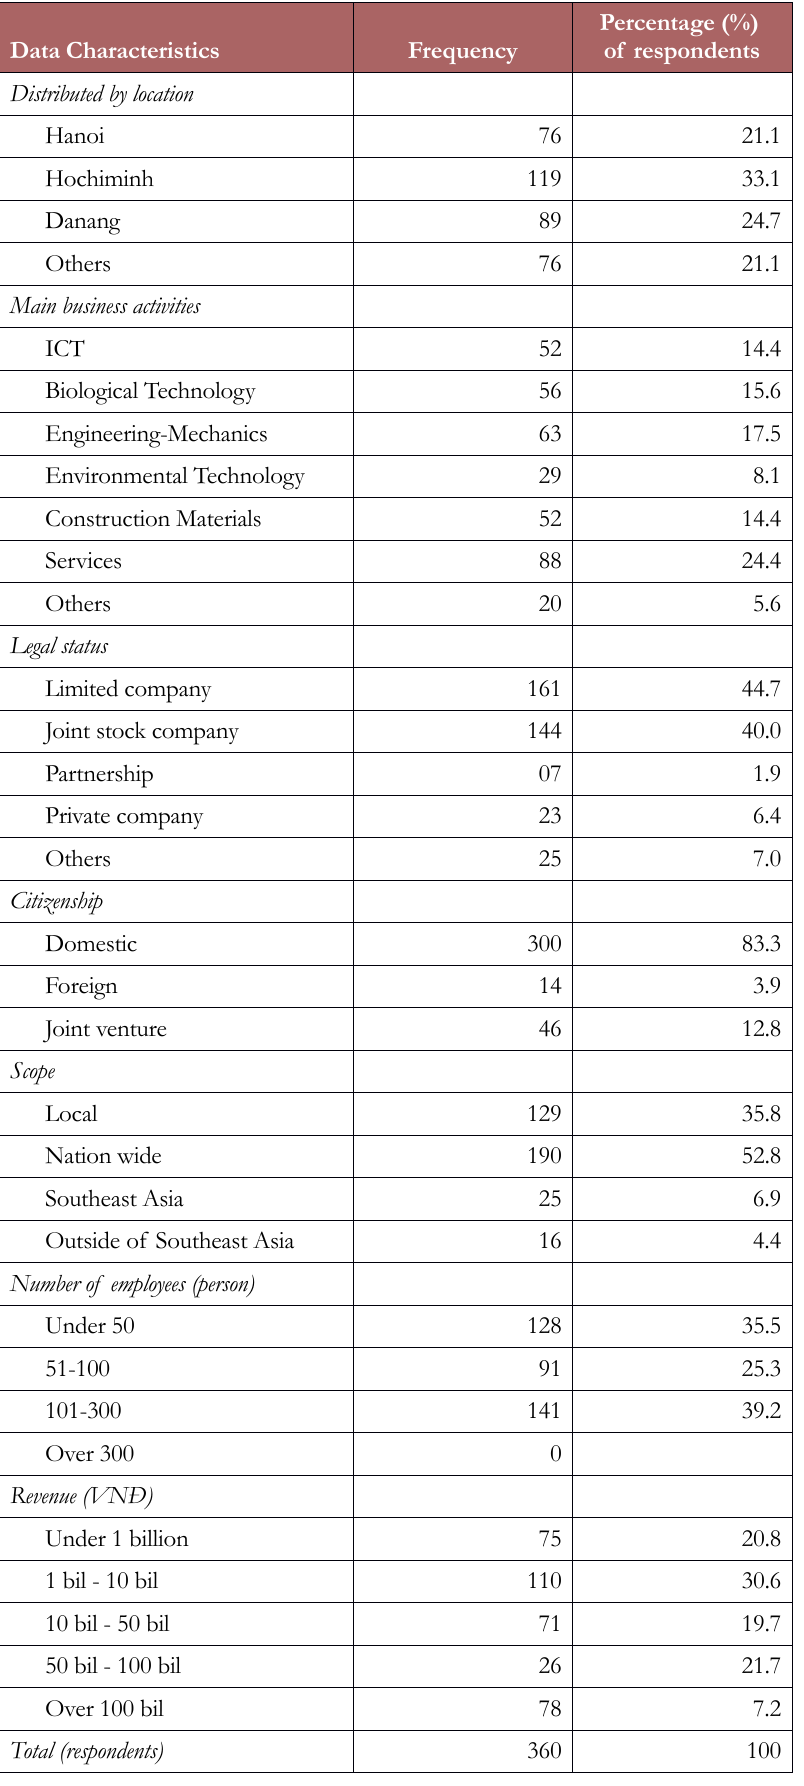
Table 1. Characteristics of the survey data (N = 360) (summarized by authors from